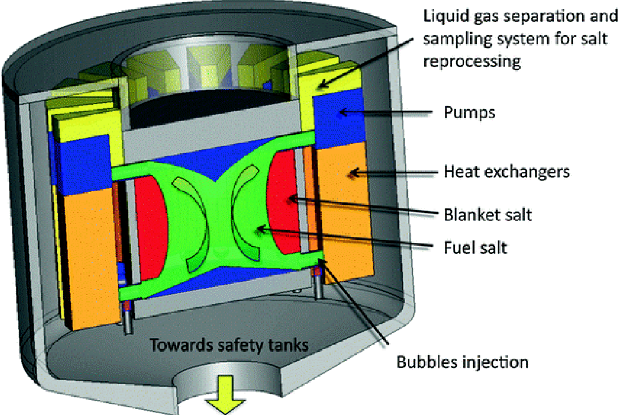
Fig. 2. MSFR fuel circuit conceptual scheme.